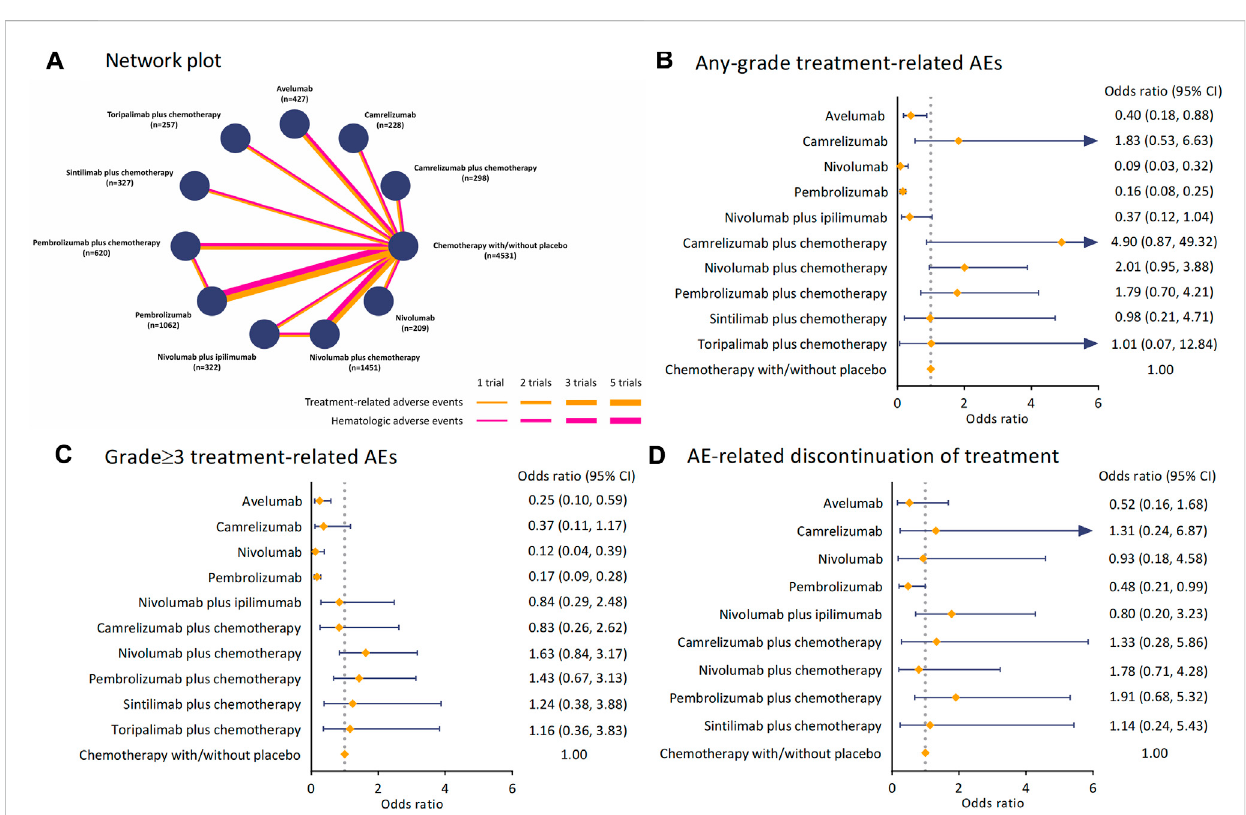
FIGURE 2 NetworkplotandpooledestimatesofcomparisonsofTRAEsandAE-relateddiscontinuationoftreatmentfromICIs. (A) Networkplotsfor16studies with hematological safety assessment in 11 interventions. Each node refers to a treatment, and each line represents a type of head-to-head comparison. (B) ORs with 95% CIs for any-grade TRAEs. (C) ORs with 95%CIs for grade ≥ 3 TRAEs. (D) ORs with 95%CIs for AE-related discontinuation of